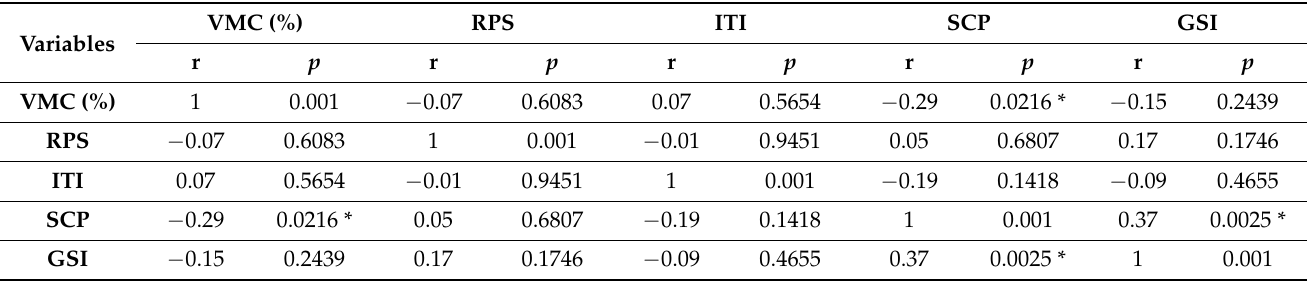
Table 5. Pearson coefficients correlations r and p for every variable VMC (%), RPS, ITI, SCP, and GSI on treatments. (*) significant